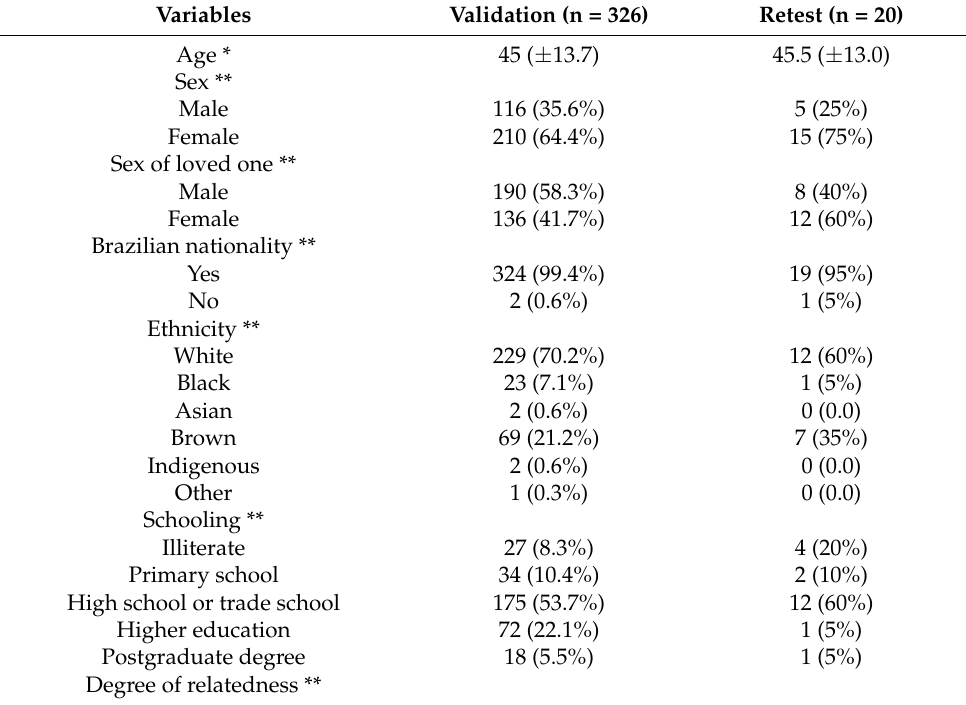
Table 2. Sociodemographic characteristics of participants in different phases of